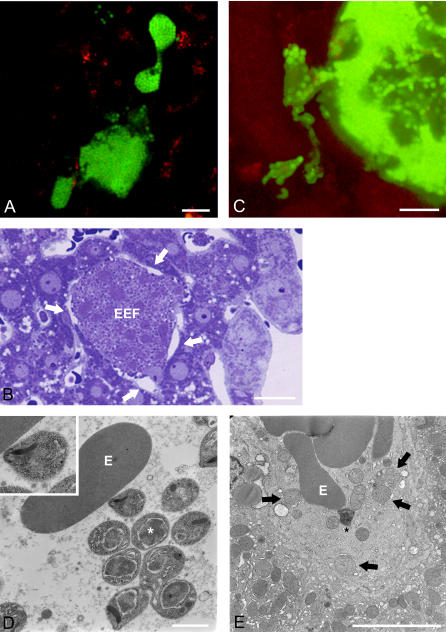
Merozoite Release by Merosome Formation(A) Intravital microscopy of merosomes budding from an EEF. Note that a few individual merozoites are located in the vicinity of the EEF (see Videos S1–S3). Bar = 10 μm.(B) Semithin Epon section showing an EEF that has lost contact with the surrounding parenchyma (arrows). Bar = 10 μm.(C) Projection of an EEF in the process of disintegration; note that the cell releases individual merozoites into the environment (see Video S4). Bar = 10 μm.(D) Electron micrograph showing merozoites located free in a liver sinusoid. The apical pole of one of the merozoites is in close contact with an erythrocyte (insert). E, erythrocyte; *, merozoites. Bar = 1 μm.(E) Liver sinusoid containing free hepatocyte mitochondria (arrows) and a free merozoite. E, erythrocyte; *, merozoite. Bar = 5 μm.